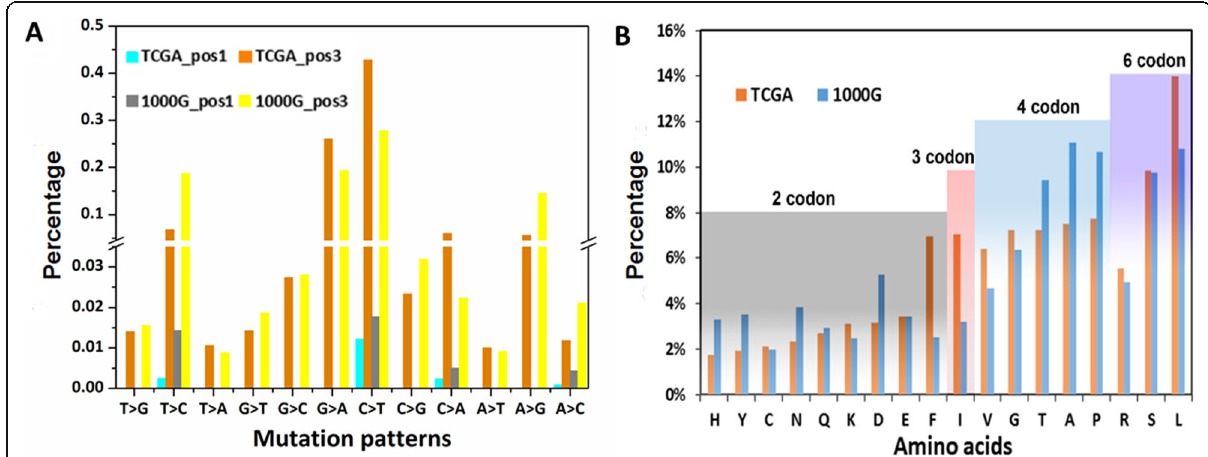
Fig. 3 Mutational signatures of synonymous mutations in TCGA and 1000G. a Distribution of synonymous mutations for the 12 mutation patterns at pos1 and pos3 of codons in TCGA and 1000G. b Proportions of 18 amino acids with two, three, four or six-fold degenerate codons under which synonymous mutations occurred. Orange bar represents the proportion of mutations in TCGA and grey bar represents that in 1000G. 2, 3, 4, and 6 codon represent the numbers of synonymous codons,